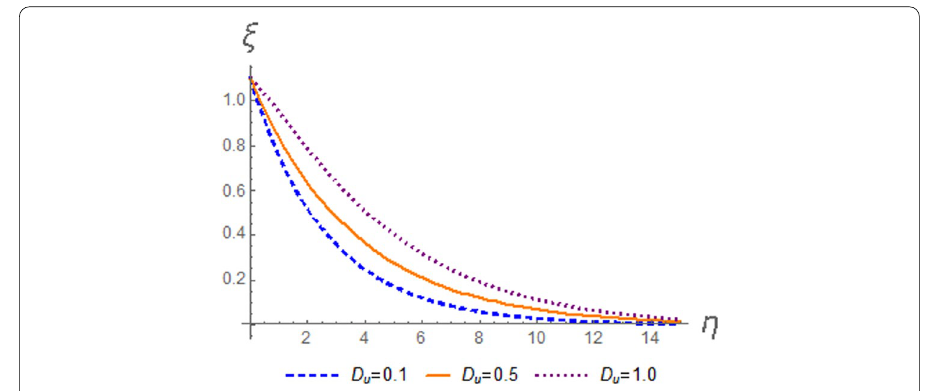
Fig. 19 Effect of D u on the temperature profile